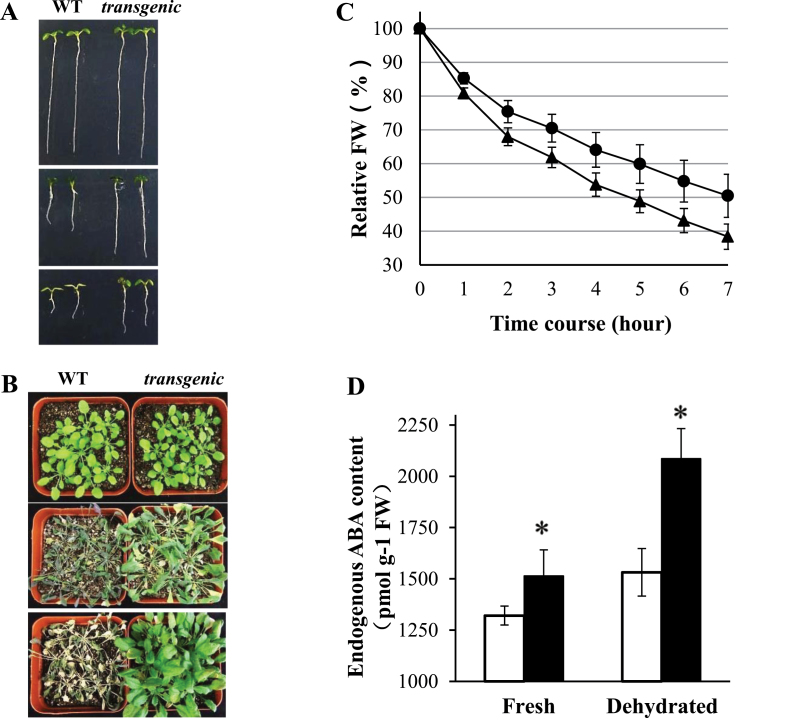
Response of WT and transgenic Arabidopsis plants to dehydration stress. (A) Response of seedlings to dehydration by mannitol and glycerol. Three-day-old ½ MS-grown seedlings were transferred to fresh ½ MS (top), ½ MS containing 300mM mannitol (middle), or 3% (v/v) glycerol (bottom) and grown for a further 7 days. (B) Drought treatment of soil-grown plants. 3-week-old plants (top) had water withheld for 22 days (middle) and were subsequently re-watered (bottom). (C) Water loss of detached leaves. Relative fresh weight (FW) is the percentage fresh weight of a leaf at a dry time point relative to its fresh weight at time 0. WT, black triangles; transgenics, black circles. The experiment was repeated three times and the data were averaged; values are means ± SE from five leaves for each experiment. (D) Endogenous ABA levels of the WT (white columns) and 35S:IgASE1 transgenic plants (black columns) estimated from untreated (Fresh) and 1-h air-dried (dehydrated) leaves. ABA concentration is expressed as pmol per gram of fresh weight. *P < 0.05 in a Student’s t test. This figure is available in colour at JXB online.